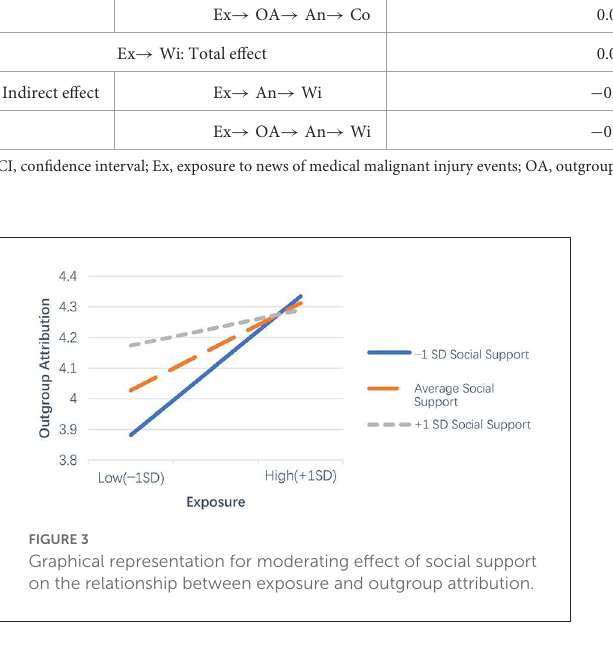
0.08, se = 0.09, t = 0.83, p = 0.408). Hypothesis 11